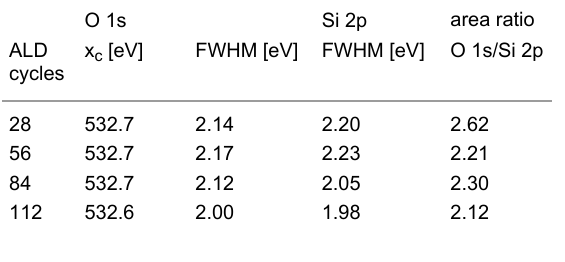
Table 2: Results of the fitting analysis of the XPS O 1s and Si 2p emis- sions (x c denotes the peak position of the O 1s contribution of silica).